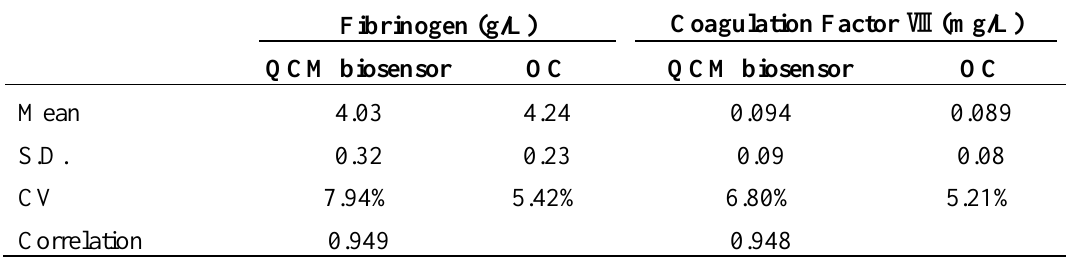
Table 1. Correlation between QCM biosensor and OC method for fibrinogen and factor VIII